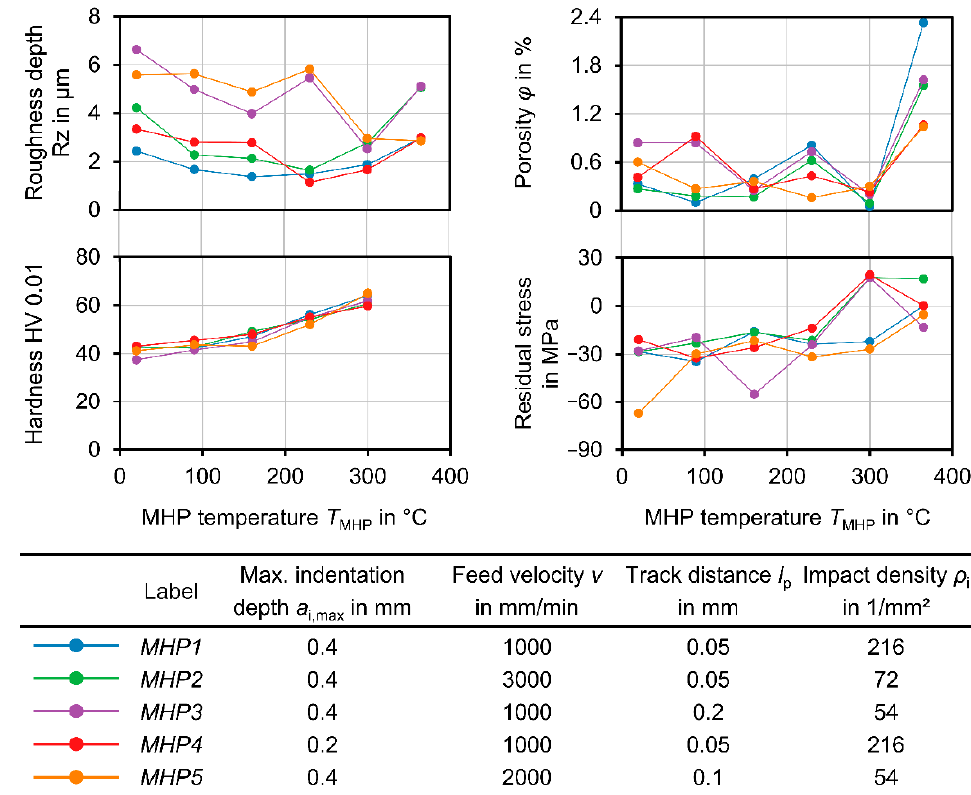
Figure 6. Characteristics of the coatings measured after different MHP treatments at temperatures between T MHP = 20 °C and T MHP = 365 °C: Roughness depth, porosity, Vickers hardness, and residual between T MHP = 20 ◦ C and T MHP = 365 ◦ C: Roughness depth, porosity, Vickers hardness, and residual stresses.